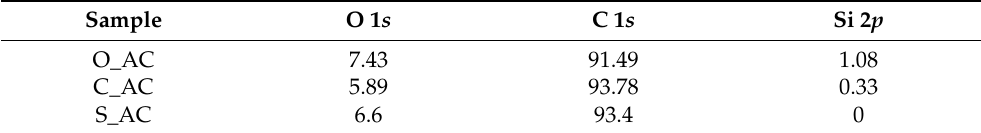
Table 4. The atomic concentrations of elements present over the surface of the obtained carbon ma- terials.